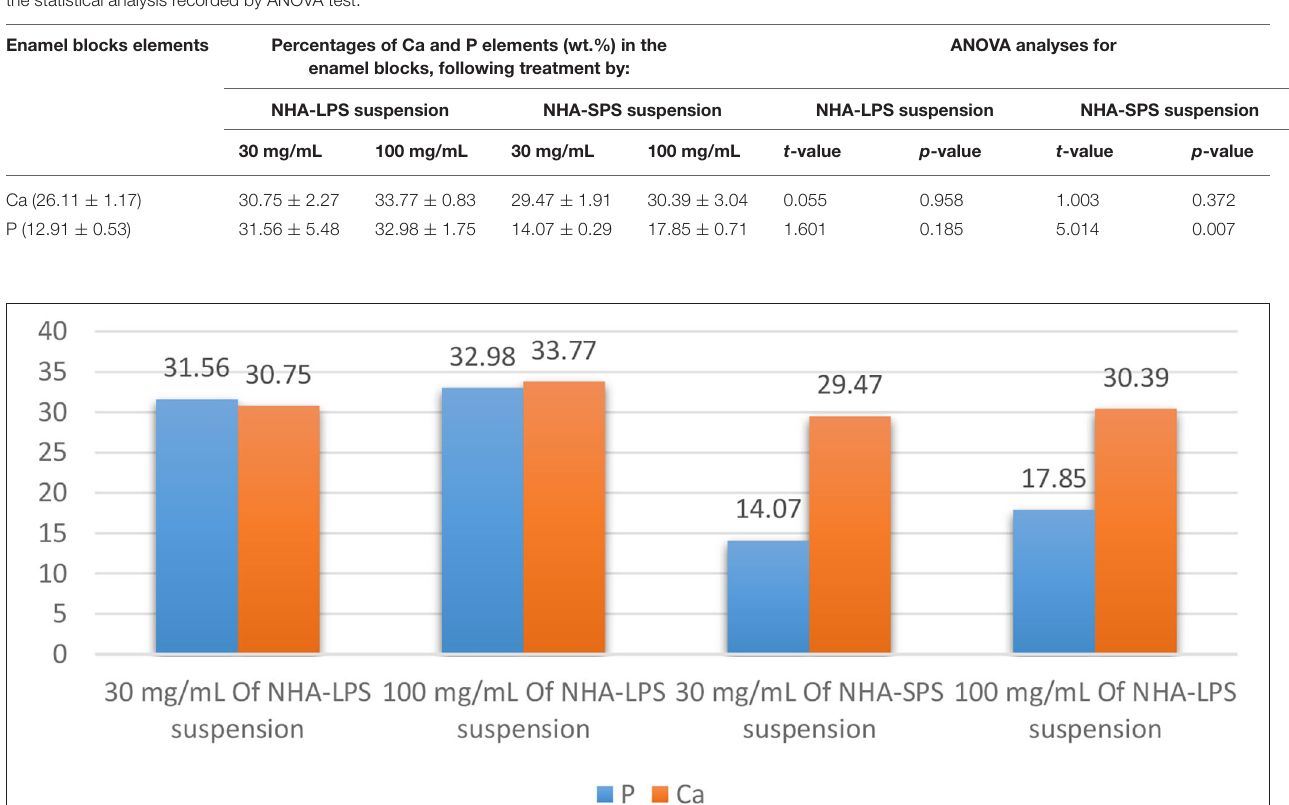
FIGURE 4 | Bar chart showing the mean (P) and (Ca) values (wt. %) throughout the steps of treating sample by 3 and 10% of 1st and 2nd aqueous suspension.